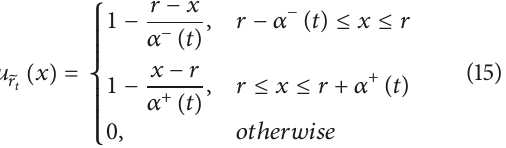
that is, the fuzzy numbers triangle-type shape, respectively, with centers 𝑏 1 , 𝑐 1 and 𝑏 2 , 𝑐 2 , and fuzzy degree factors behind fuzzy external market shocks and counterparty